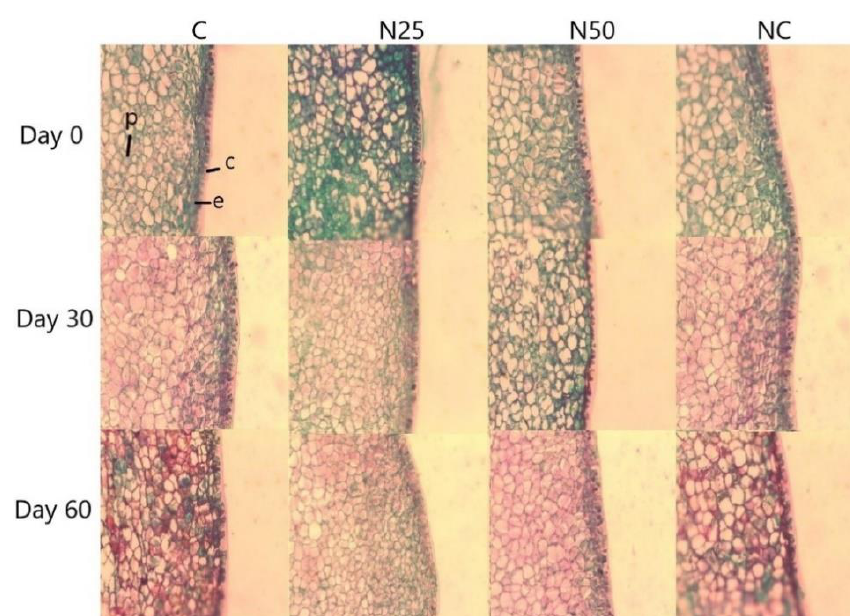
Figure 2. Structural evaluation of the avocado epicarp with respect to time. The columns indicate the same treatment with respect to time and the rows indicate the same day of analysis for different treatments, c = cuticle, e = epidermis, p = parenchyma.